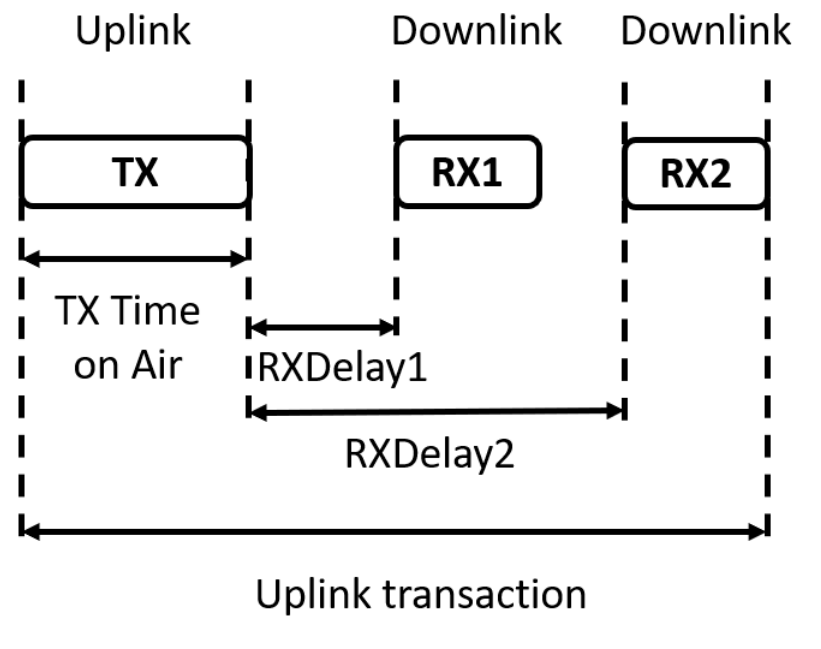
Figure 2. Uplink transaction of Class-A